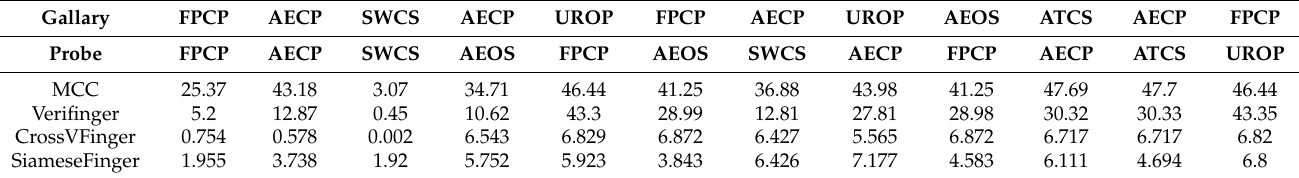
Table 5. Comparison of the performance of SiameseFinger with the state-of-art methods on FingerPass database in terms of EER. Gallary